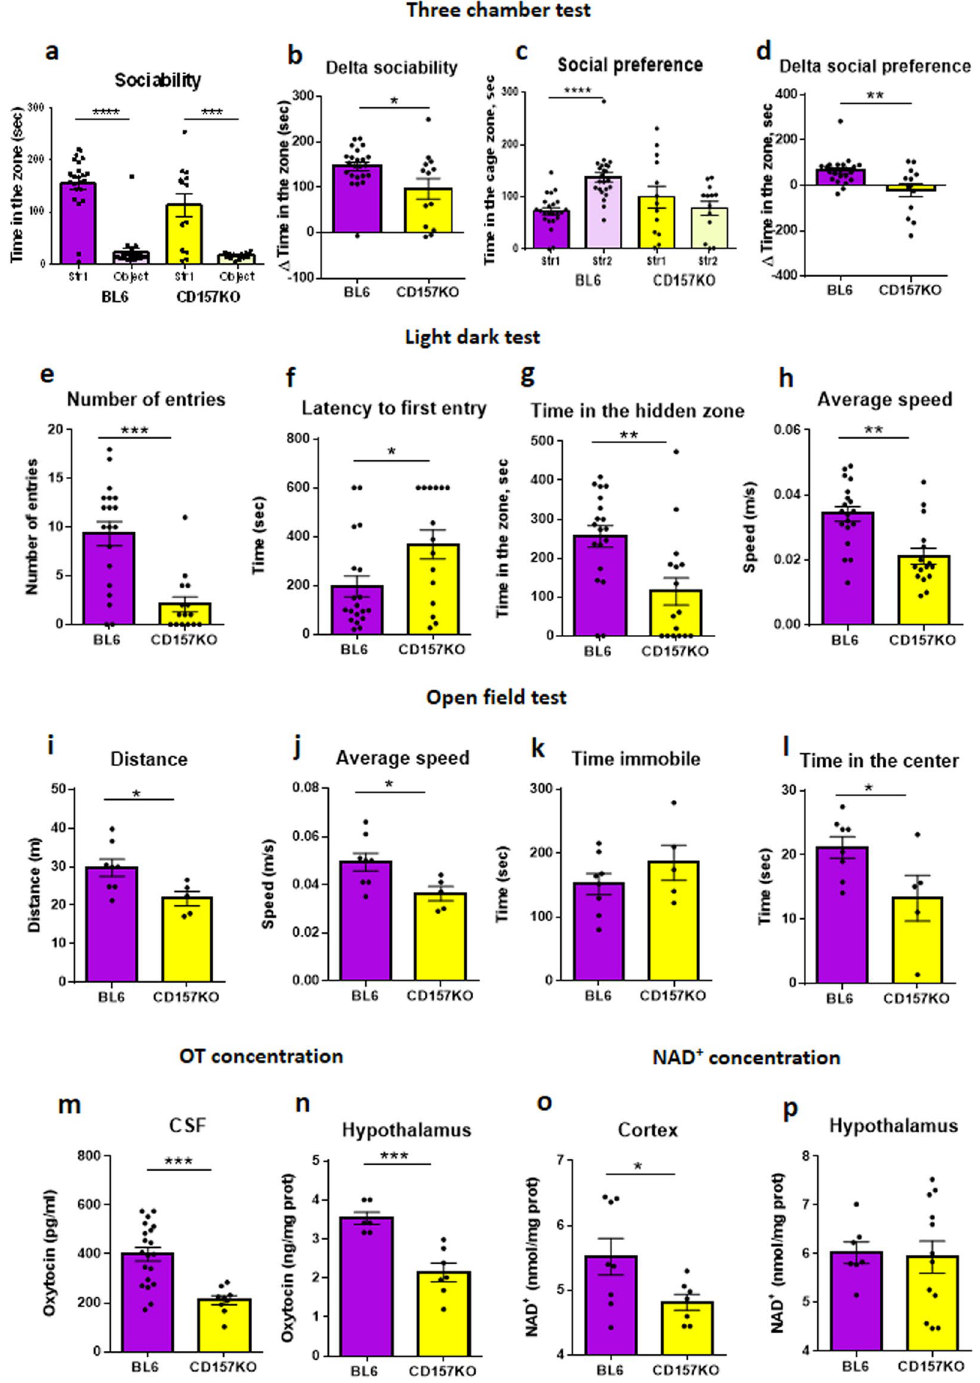
Figure 1. Social behaviour of adult wild-type (BL6) or CD157KO male mice. ( a–d ) Three chamber test. ( a ) The Sociability stage. Time spent around wire mesh cages with the social target (a conspecific male mouse, stranger 1, str 1) or with a non-social object (usually a plastic test tube, object). ( b ) Delta sociability (the time difference spent between the social and nonsocial targets calculated from ( a )). ( c ) Social preference (time spent with the familiar mouse, str1, or with new mouse, str2. ( d ) Delta social preference (the time difference spent between the unfamiliar and familiar social targets calculated from ( c )). ( e – h ) The light-dark transition test. ( e ) The number of entries from light to dark zone. ( f ) Latency to the first entry from the light to dark zones. ( g ) Time spent in the hidden zone. ( h ) The average speed in the light zone. ( i – l ) The open field test. ( i ) The distance traveled in all arenas ( i ), average speed ( j ), immobile time ( k ), and time spent in the center zone ( l ). Oxytocin concentrations in the cerebrospinal fluid (CSF, m ) and the hypothalamus ( n ). NAD + concentrations in the cortex ( o ) and hypothalamus ( p ). Unpaired t -test. * P < 0.05; ** P < 0.01; *** P < 0.001; **** P <